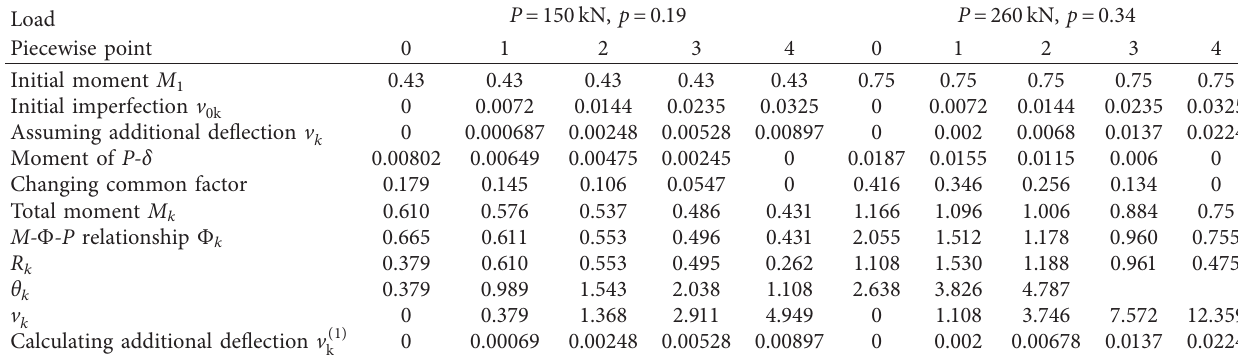
Table 5: Deformation calculations of steel columns.